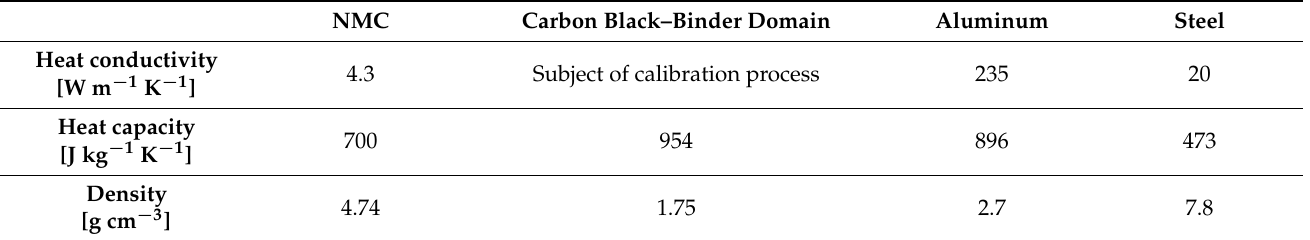
Table 1. Structural parameters of the model